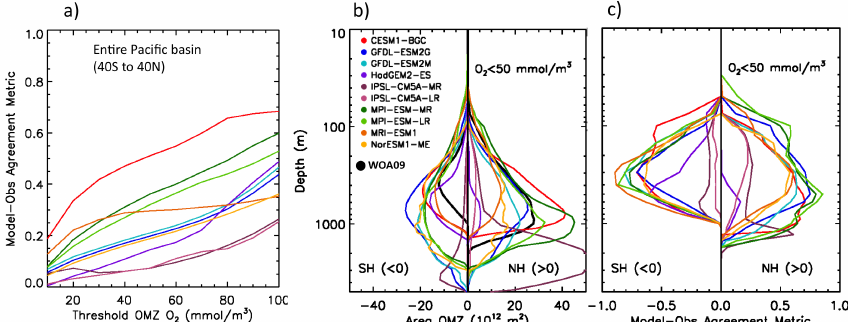
Figure 7. Agreement between modelled and observed OMZ extension in the Pacific during the historical period (1960–1999). (a) The agree- ment of modelled OMZs with observations is shown as the ocean volume that results from the intersection of the modelled and observed OMZs, divided by the volume that encompasses both modelled and observed OMZs. The OMZ volume is calculated at different O 2 thresh- olds ( x axis). (b) Area of low-oxygen waters (O 2 <50mmolm − 3 ) at each depth across CMIP5 models and observations in the Southern Hemisphere (SH) (0–40 ◦ S; negative values) and in the Northern Hemisphere (0–40 ◦ N; >0) as labelled. (c) Agreement of modelled OMZs with observations at each depth, shown separately for SH (0–40 ◦ S; <0) and Northern Hemisphere (NH) (0–40 ◦ N; >0). The agreement is calculated as in (a) and goes from 0 (no agreement) to 1 (perfect agreement). The model HadGEM2-CC (not shown) shows results similar to